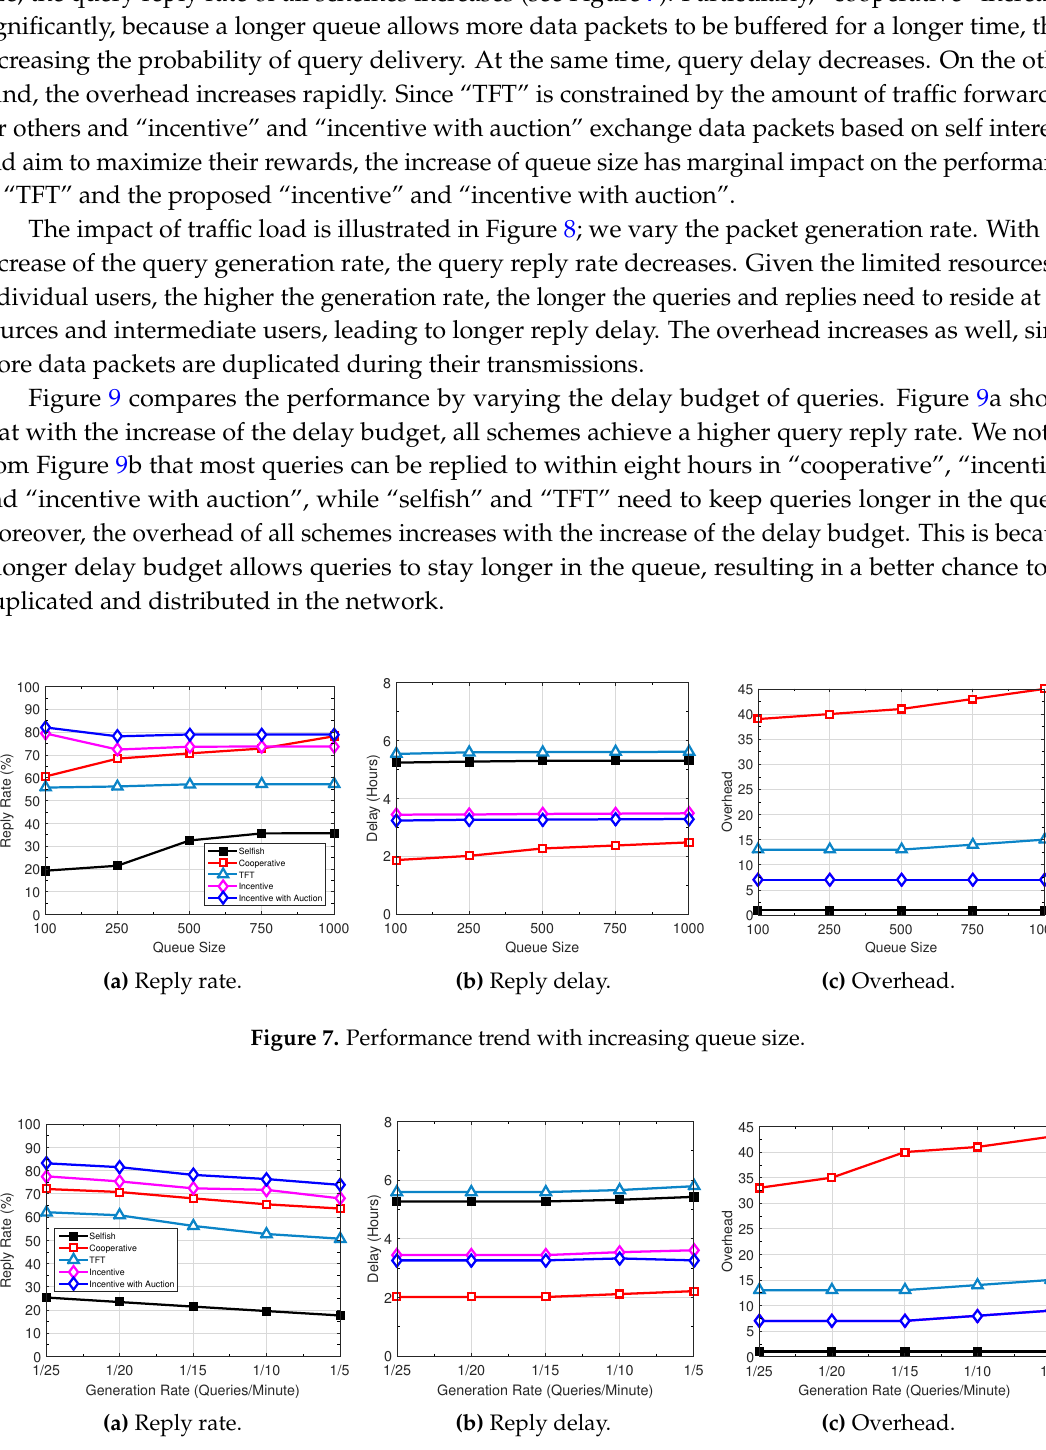
Figure 8. Performance trend with increasing generation